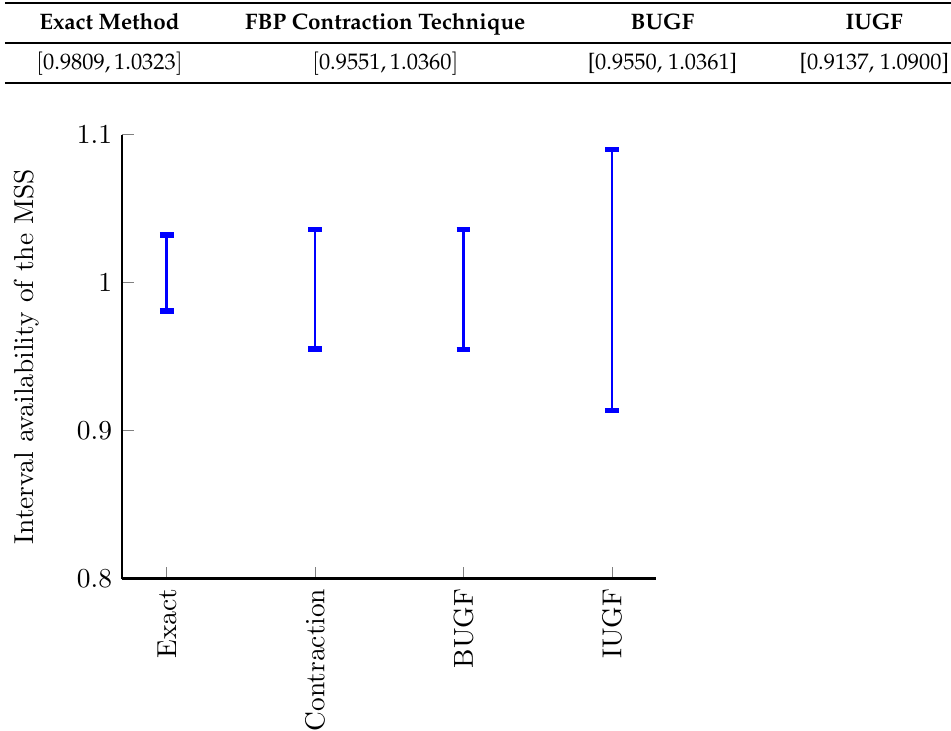
Figure 7. The interval availability of the system obtained using each